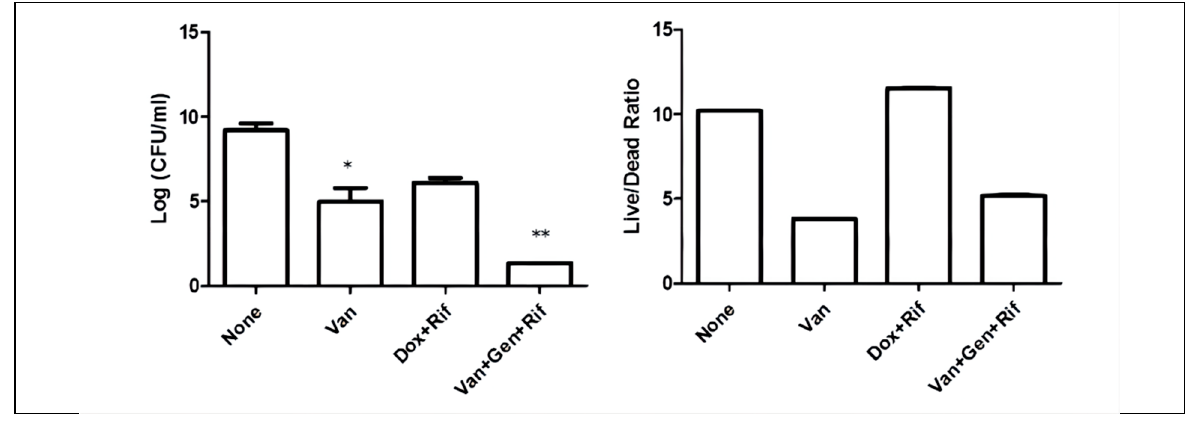
Figure 1. Clinically recommended treatments for chronic S. aureus infections only partially killed S. aureus USA300 biofilm bacteria in vitro. Treatments (all 50 µ M) of vancomycin alone, doxycycline + rifampin, and the combination of vancomycin + gentamicin + rifampin for 4 days were evaluated for biofilm killing by CFU enumeration ( A ) and viability staining using SYBR Green I/PI ( B ). See Methods section for details. Vancomycin, Van; Doxycycline, Dox; Rifampin, Rif; Gentamicin, Gen. Student’s t -test, * p < 0.05, ** p < 0.005. Error bars indicate standard